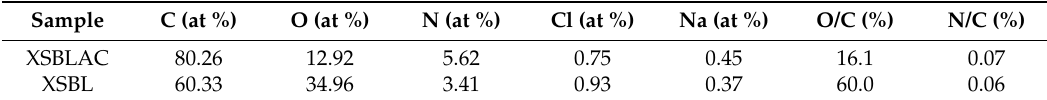
Table 2. Global Surface Composition as Determined by EDX Analysis.